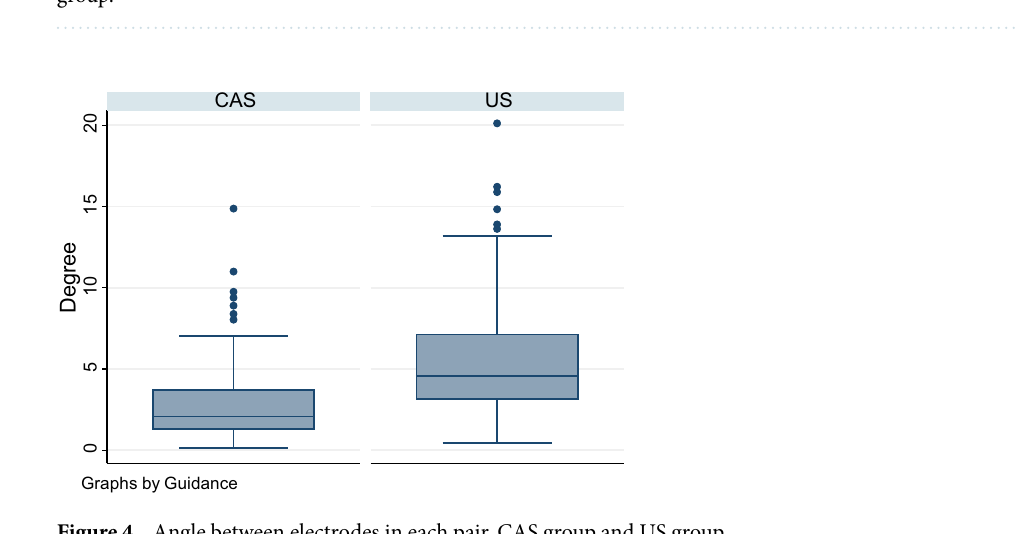
Figure 4. Angle between electrodes in each pair, CAS group and US